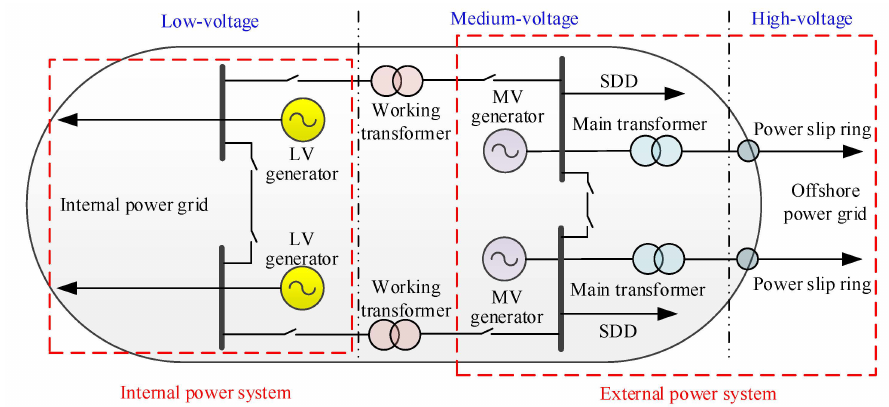
Figure 1. Schematic diagram of the typical structure of a floating nuclear power